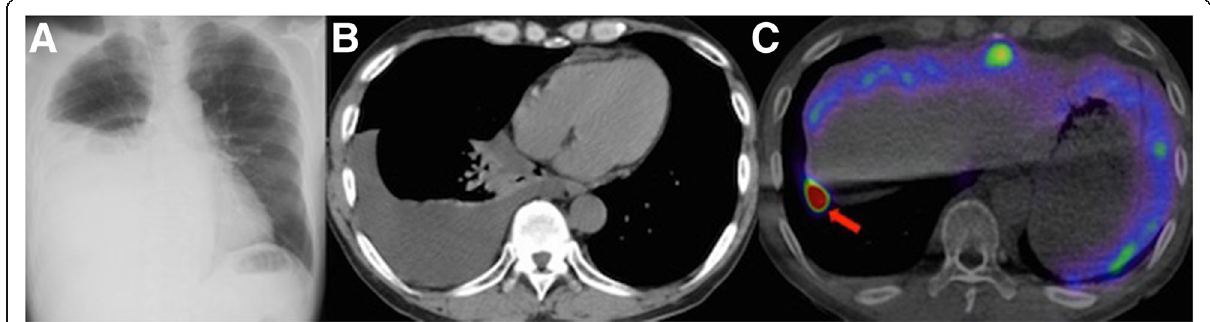
Fig. 1 Imaging findings. a Chest X-ray radiogram of 65-year-old man with chronic renal failure. Chest X-ray showed a right hydrothorax. b Chest computed tomogram (CT) of the patient. Chest CT showed hydrothorax in the right thoracic cavity. c Chest 99m Tc-macro-aggregated albumin ( 99m Tc-MAA) radioscintigraphic image of the patient. 99m Tc-MAA was administered into the peritoneal cavity with dialysate, and 450 min later, a leakage of the dialysate into the right pleural cavity was detected (red arrow)